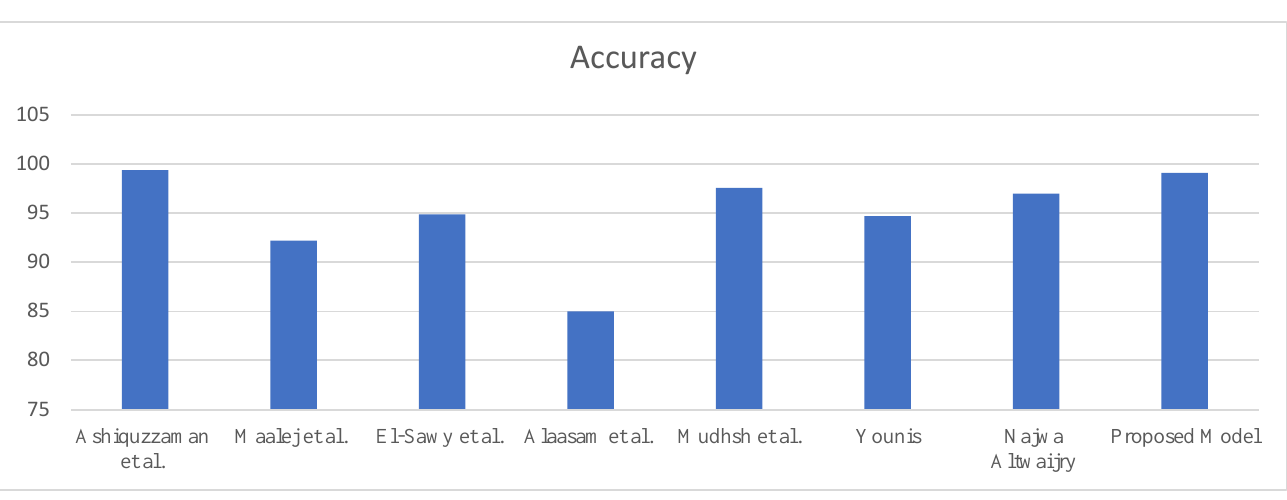
Figure 3. Showing the Accuracy